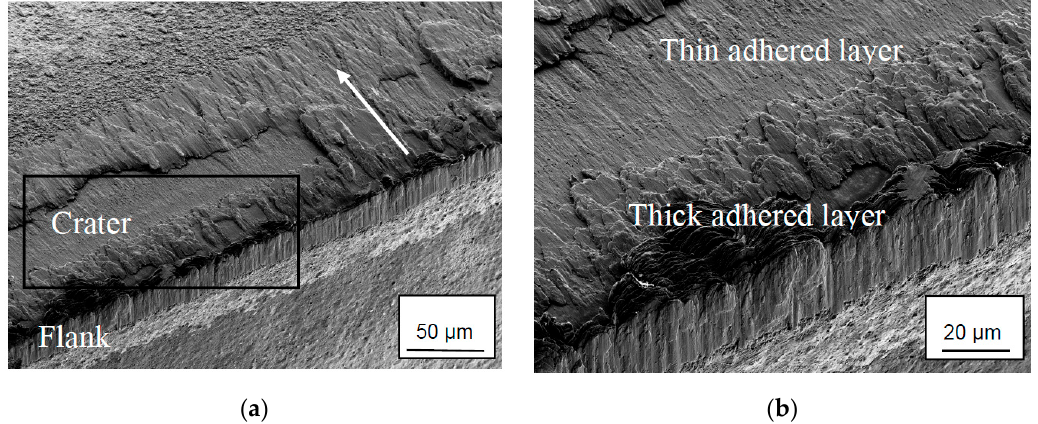
Figure 4. ( a ) Wear characteristics of cemented carbide insert showing the crater and flank wear regions. Cutting parameters: v c : 90 m/min, f n : 0.2 mm, t : 0.5 min. The arrow shows the chip flow direction. Note the transfer of work material to the crater and flank wear regions and especially to the cutting edge and close to the depth-of-cut. ( b ) Detail of ( a ) showing transferred work material covering the worn cemented carbide.